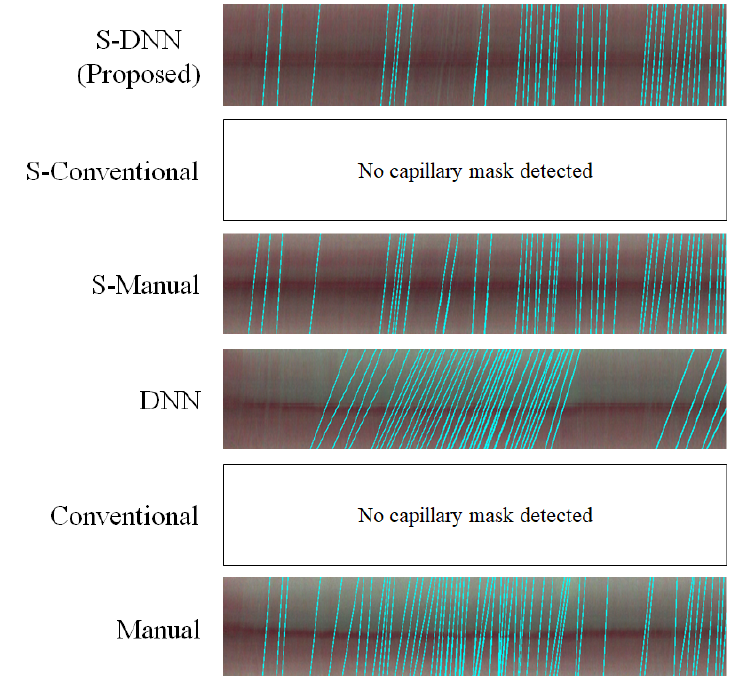
Figure A2. Events reconstructed from event counting using various methods for capillary